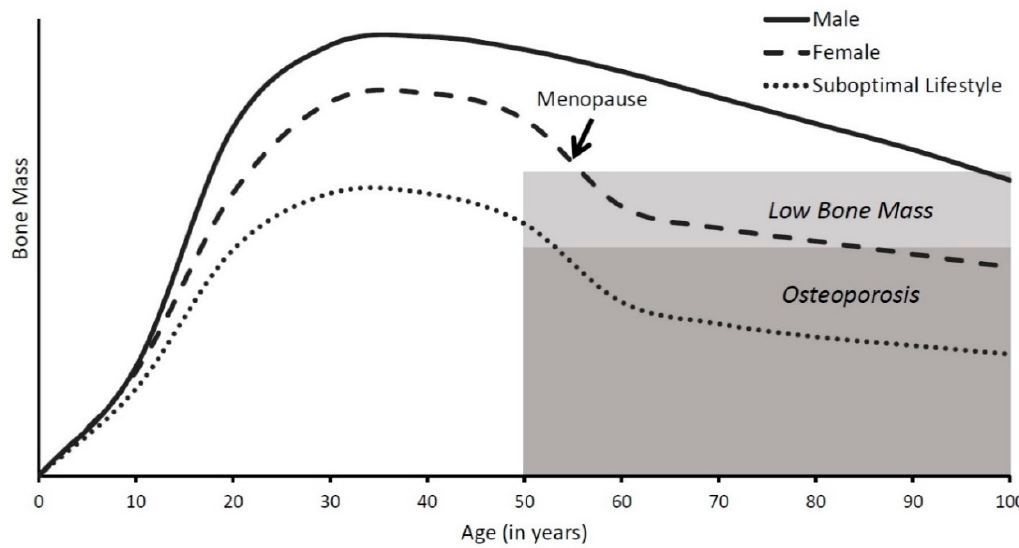
Figure 1. Bone mass throughout the life span. Bone accumulates rapidly in childhood and grows at maximal rates during puberty. Peak bone mass is reached by age 30, and then slowly decreases. Females typically accumulate less bone mass than males and rapidly lose bone during menopause, making them more susceptible to osteoporosis later in